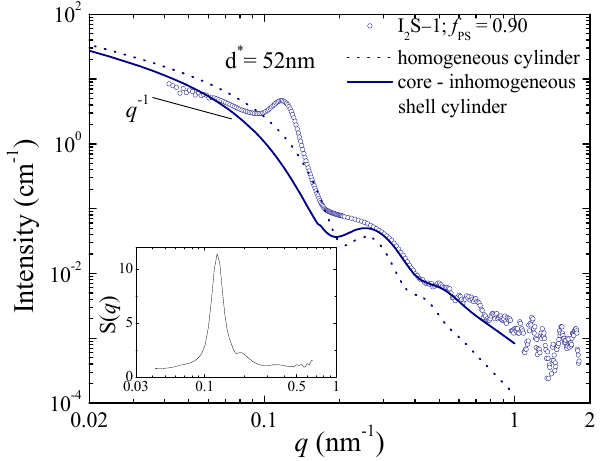
Figure 4. The scattering profile for the 2 wt% blend of the I 2 S − 1 graft copolymer within the polyisoprene matrix at room temperature. The simulated scattering curves for homogeneous cylinders with R = 19.8 nm (dotted line) and for core-shell cylinders with inhomogeneous shell and an inner radius of 22 nm and an outer one of 30 nm (solid line) are included as well. The inset shows the structure factor estimated using the scattering data and the form factor of the core-inhomogeneous shell cylinders.